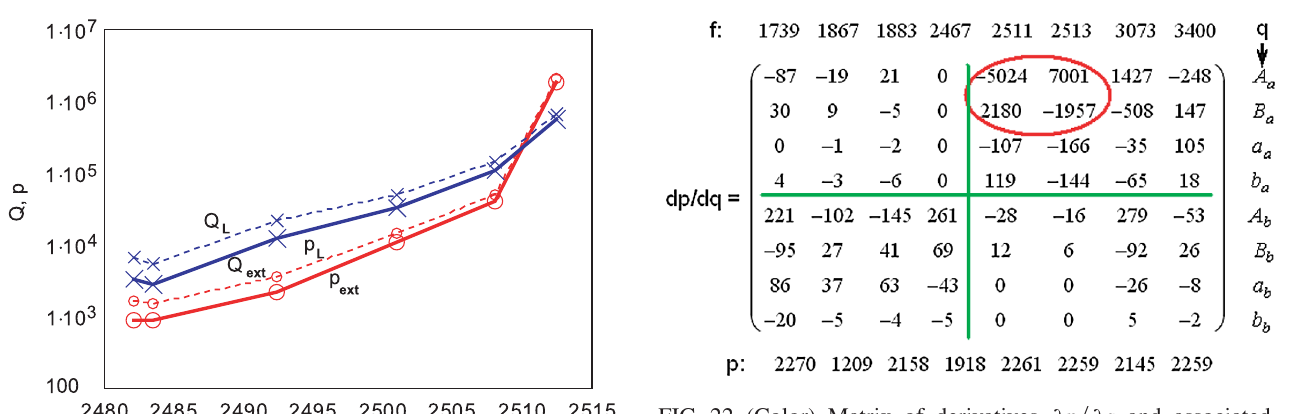
FIG. 22. (Color) Matrix of derivatives @p=@q and associated frequencies, p ’s, and q ’s.